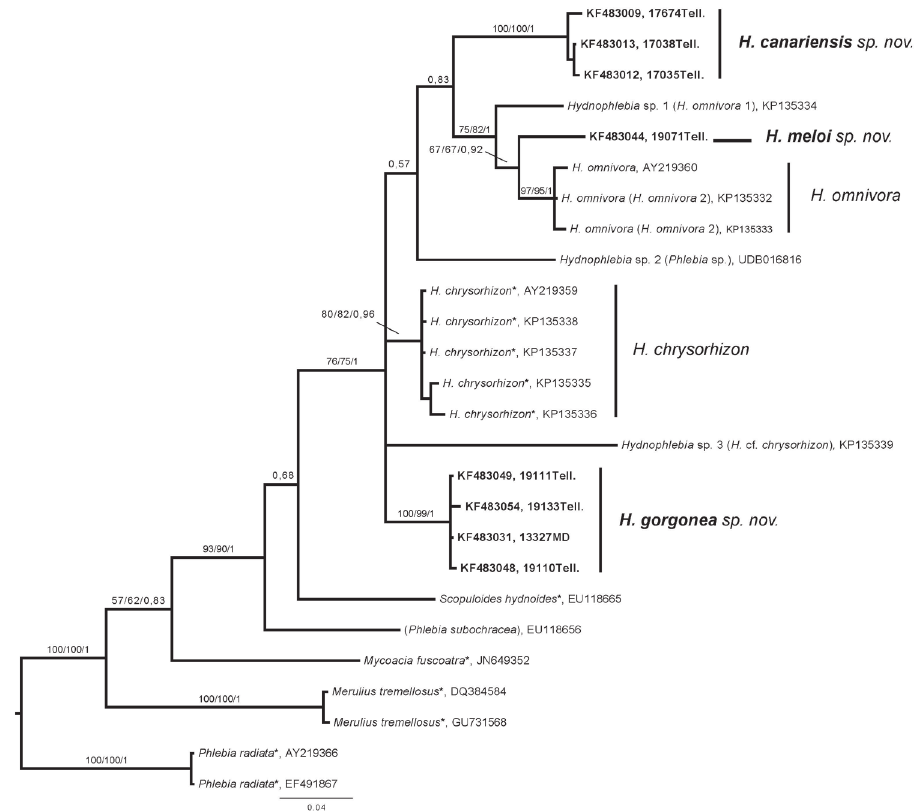
Figure 2. The 50% majority rule Bayesian tree inferred from ITS nrDNA assuming the GTR + I + G model of corticioid fungi included in Table 1. Parsimony bootstrap values (> 50%), maximum likelihood bootstrap values (> 50%) and Bayesian posterior probabilities (> 0.95) are indicated on the branches. Taxon name between parentheses indicate specimens with uncertain generic placement . Sequences of the new species described in this paper, H. canariensis, H. gorgonea and H. meloi are in bold. The asterisk (*) after the taxon names denotes type species of the